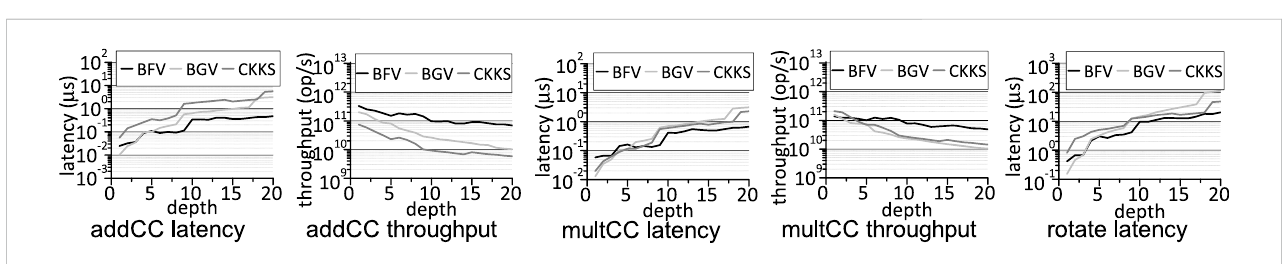
FIGURE 7 The latency and throughput comparison of server operations on an FHE hardware accelerator between various FHE schemes.